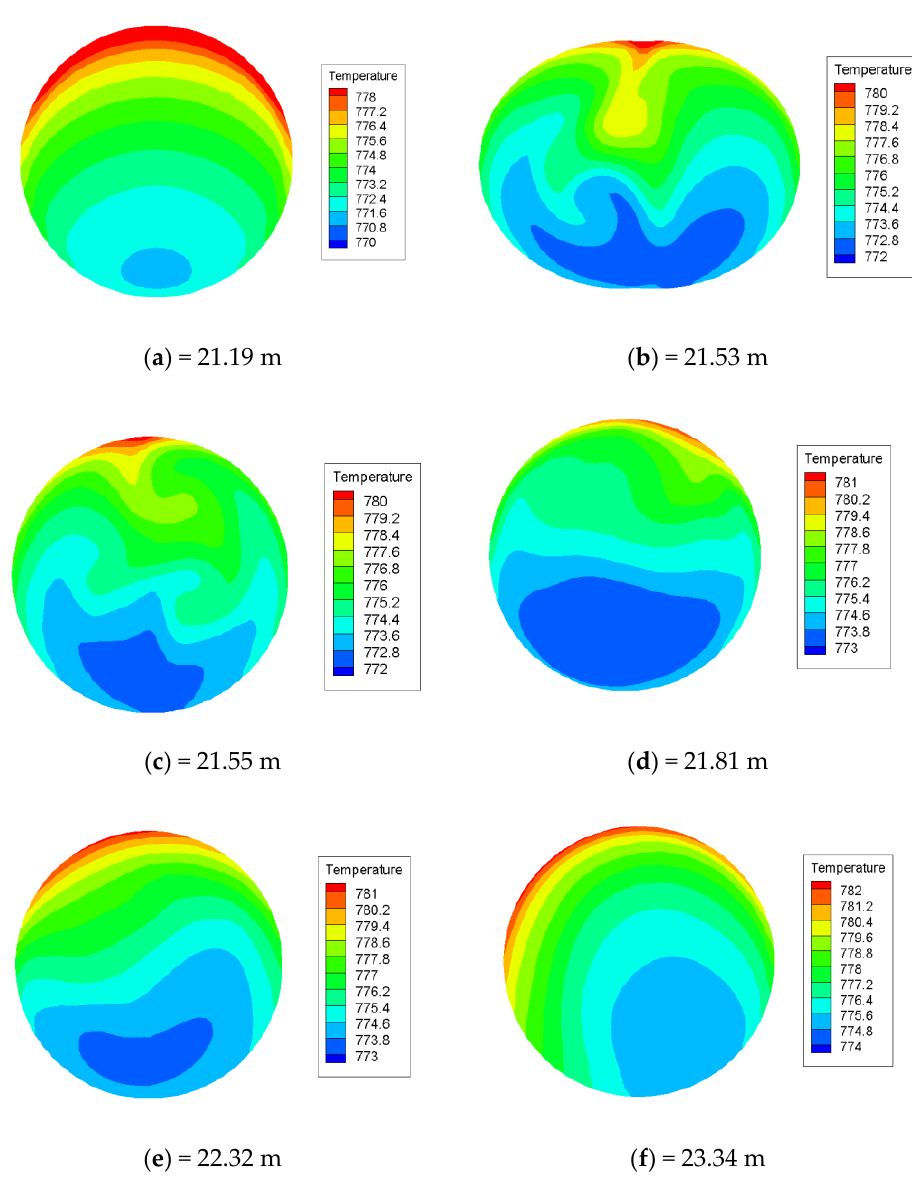
Figure 18. Temperature distribution at different sections.